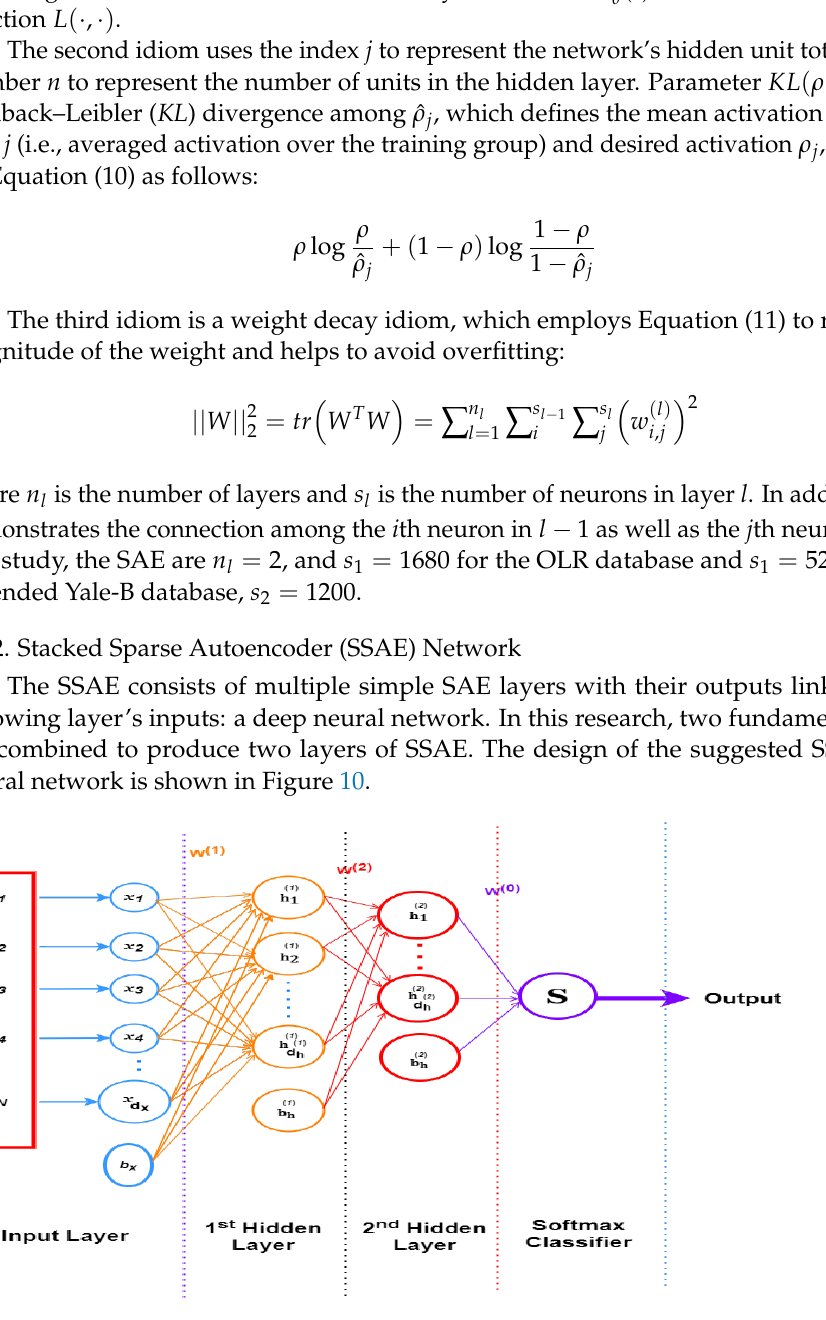
Figure 10. A proposed stacked sparse autoencoder (SSAE) architecture for face recognition with soft-max classifier [9,26].